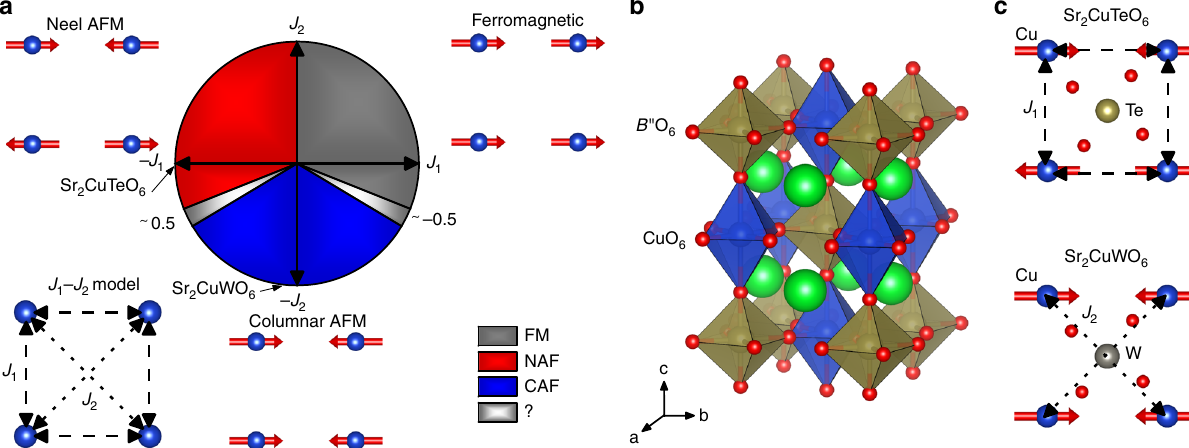
Fig. 1 Spin-1/2 Heisenberg square-lattice model in Sr 2 CuTeO 6 and Sr 2 CuWO 6 . a Phase diagram of the J 1 – J 2 square-lattice model. J 1 is the nearest-neighbor interaction and J 2 the next-nearest-neighbor interaction. The classical ground states are ferromagnetic (FM), Néel antiferromagnetic (NAF) and columnar antiferromagnetic (CAF) ordering. The highly frustrated J 2 / J 1 ≈ 0.5 and J 2 / J 1 ≈ – 0.5 regions are located at the NAF – CAF and CAF – FM boundaries, respectively. b The double perovskite structure of Sr 2 CuTeO 6 and Sr 2 CuWO 6 . Sr, Cu, B ” (Te/W) and O are represented by green, blue, dark yellow and red spheres, respectively. The blue (dark yellow) octahedra represent CuO 6 ( B ” O 6 ). c The Néel antiferromagnetic structure of Sr 2 CuTeO 6 and the columnar antiferromagnetic structure of Sr 2 CuWO 6 with the view down the c -axis. The dominant antiferromagnetic interactions are